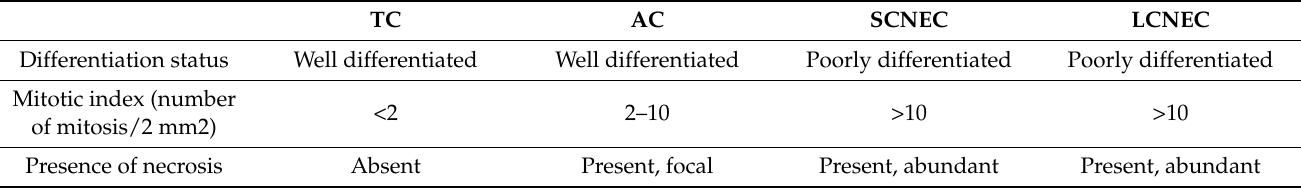
Table 3. Classification of lung NENs (2021)